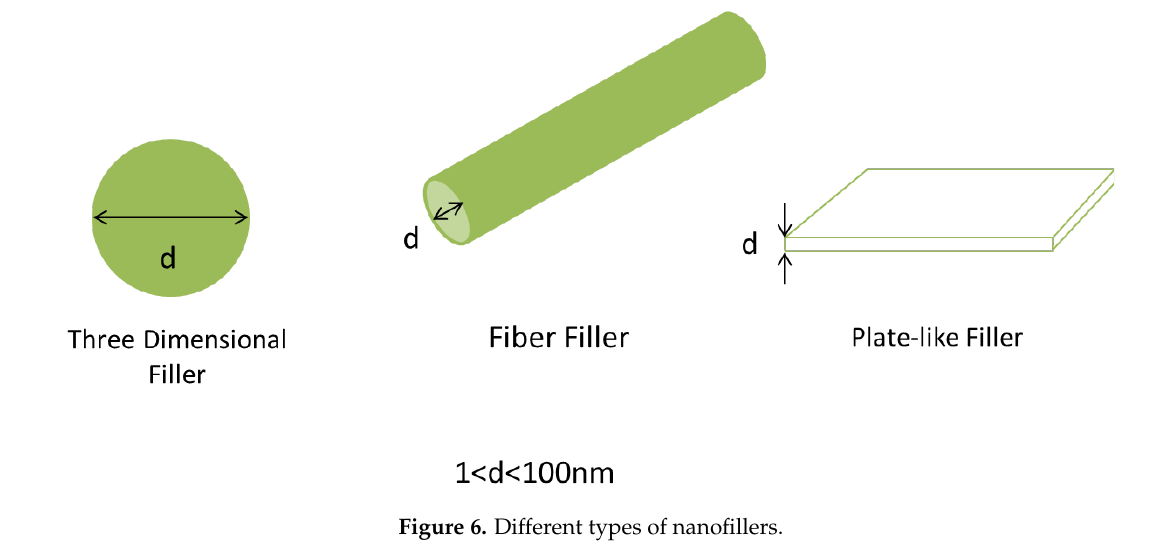
Figure 6. Different types of nanofillers.